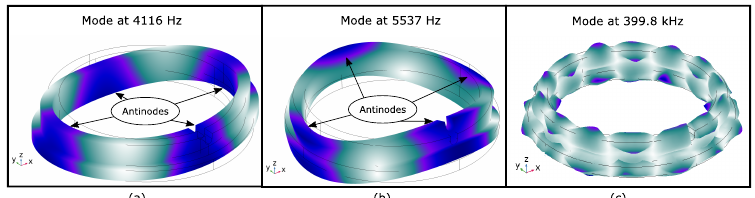
Figure 5. Selected modes of the stationary ring for graphical illustration. ( a ) Mode at 4116Hz. The ring has 4 antinodes, and the preferred direction of oscillation is in the xy-plane ( b ) Mode at 5537Hz. The ring also has 4 antinodes, but the preferred direction of oscillation is in the z-direction. ( c ) Mode at 399.8kHz. The preferred oscillation direction is no longer unique, and the size of an antinode is smaller than that in ( a , b